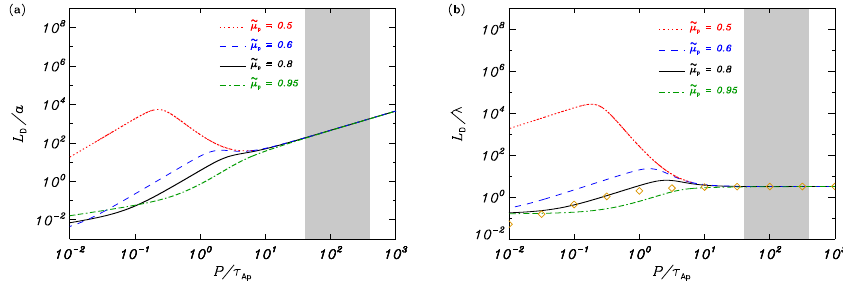
Fig. 78 Results for the kink mode spatial damping in an infinitely long prominence thread, in the case l / a (cid:15)= 0: a L D / a and b L D /λ versus P /τ Ap for ˜ μ p = 0 . 5, 0.6, 0.8 and 0.95, with l / a = 0 . 2. Symbols in ( b ) correspond to the analytical solution in the thin tube approximation. The shaded area denotes the rangeofobservedperiodsofthreadoscillations.ImagereproducedwithpermissionfromSoleretal.(2011), copyright by